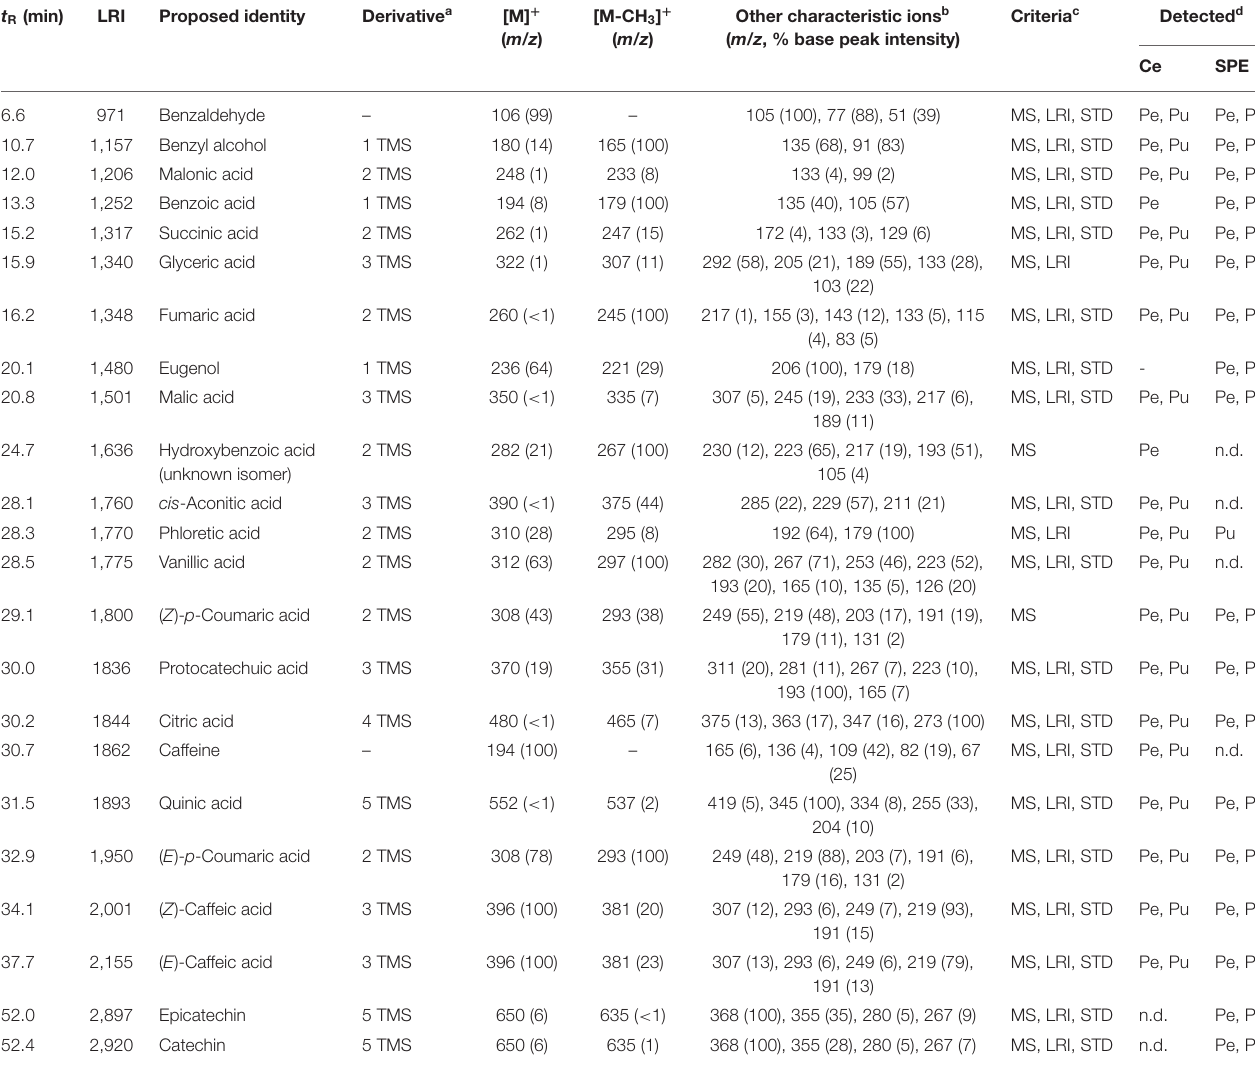
TABLE 4 | GC-MS analysis of methanolic extracts from coffee peel and pulp after alkaline hydrolysis, liquid-liquid extraction with ethyl acetate and trimethylsilylation. t R (min)